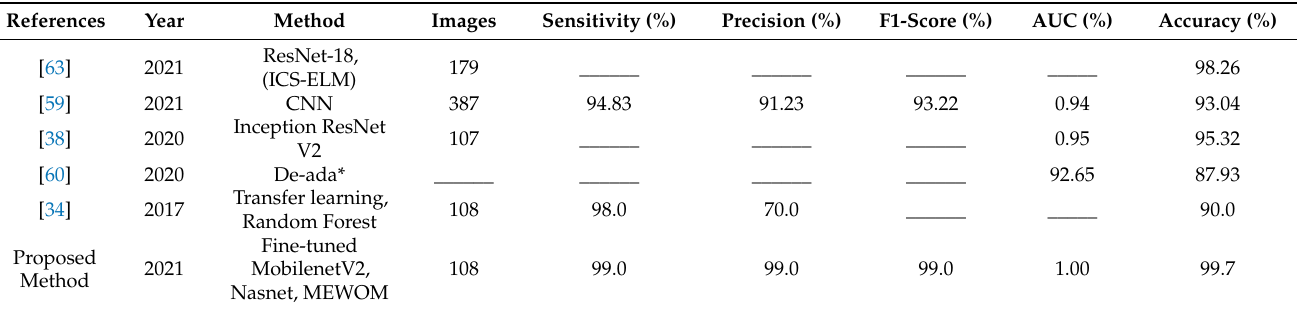
Table 22. Comparisons with state of art for INbreast